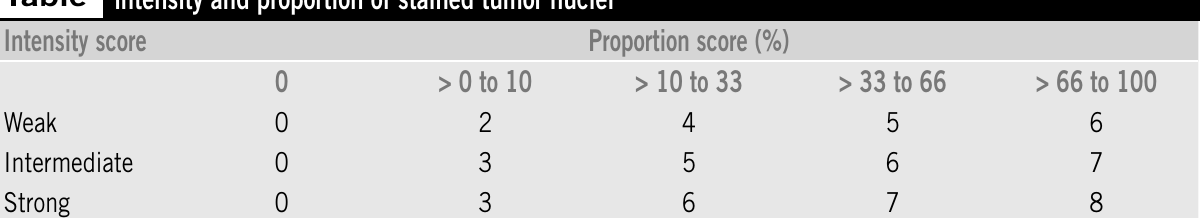
Allred’s scoring system for ER evaluation in breast carcinomas obtained by the combination of intensity and proportion of stained tumor